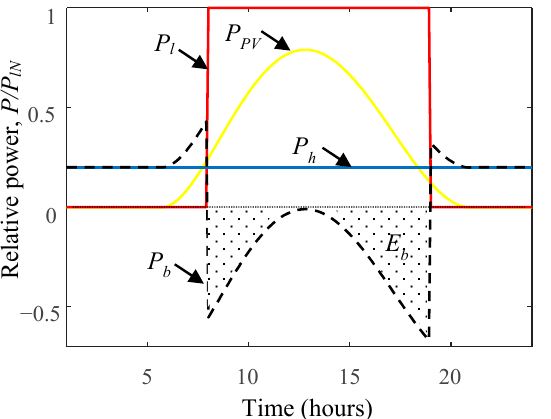
Figure 7. Hourly power profiles of load (red), PV (yellow), hydropower plant (blue), and battery (dashed black) related to nominal load power.